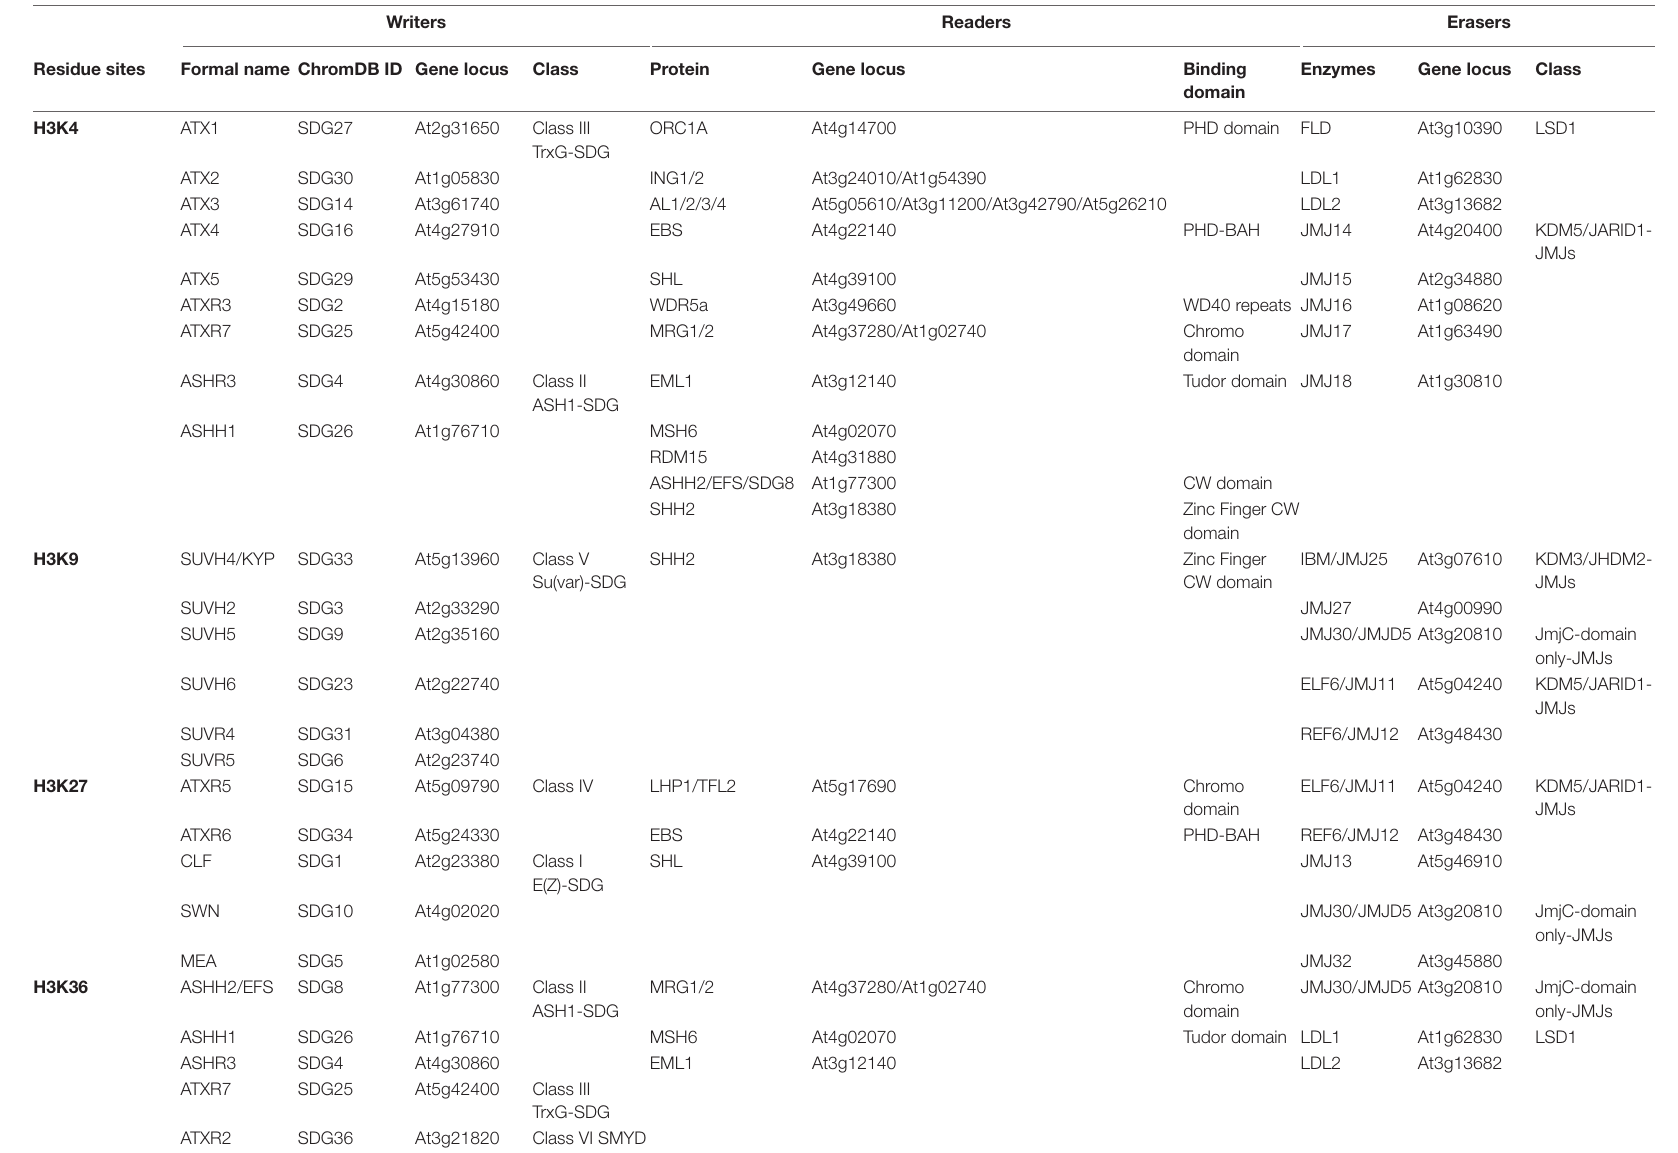
TABLE 1 | Summary of key writers, readers, and erasers for H3 lysine